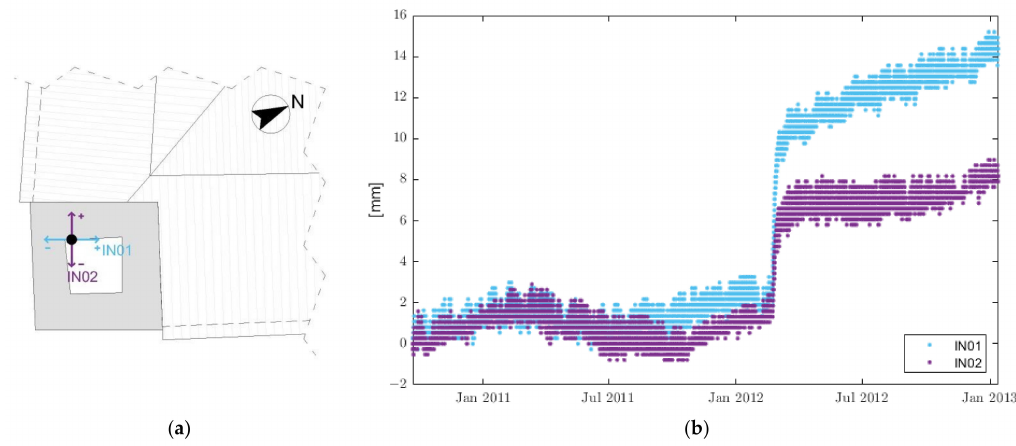
Figure 6. Layout of the inclinometers ( a ). Displacement recorded by the inclinometers at the top of the tower ( b